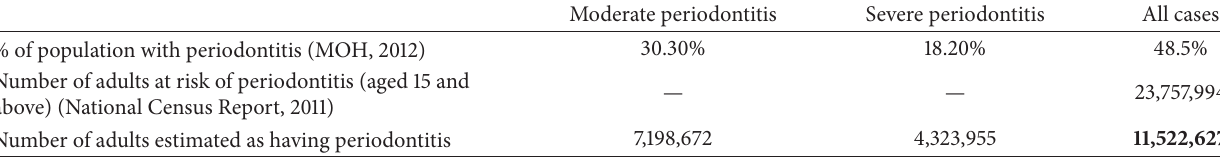
Table 2: Clinical burden of periodontitis based on national epidemiological findings and census report.